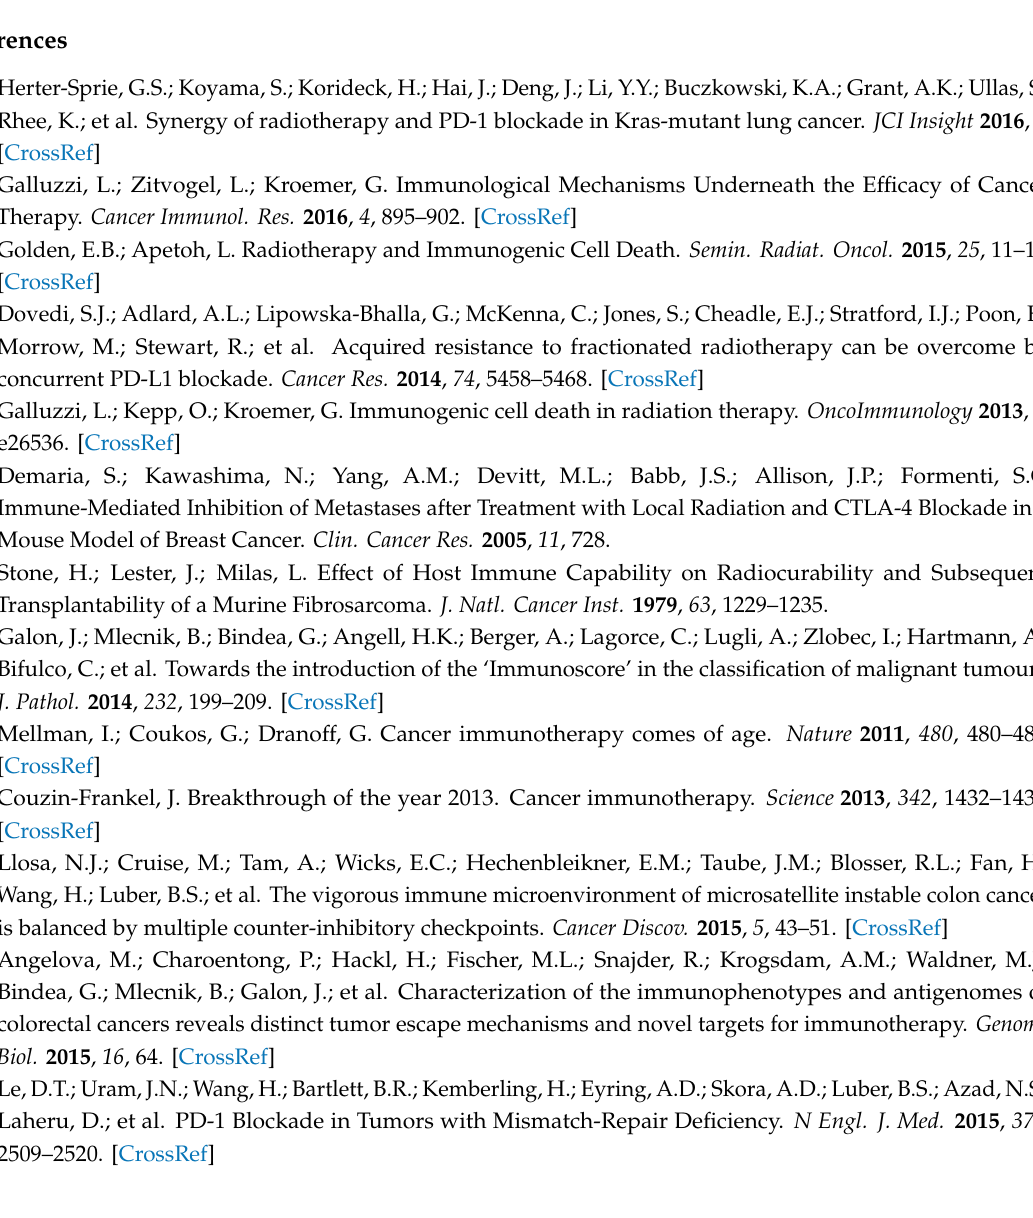
samples exemplifying how real tissue microarray cores miss immune cell clusters. Figure S2: Process of digital analysis of CD8 marker expression using StrataQuestTM ®